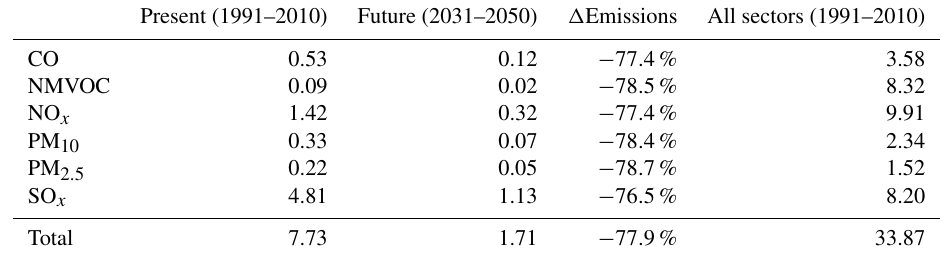
Table 2. Annual (for 2010) ACCMIP emissions of regulatory air pollutants produced by the energy sector, as used in the simulations (in Mt) of the SNAP sector representing energy production in the present scenario and projected future emissions under a mitigation scenario taking ACCMIP present emissions as the basis. The last column indicates the total emissions in the domain from all sectors.